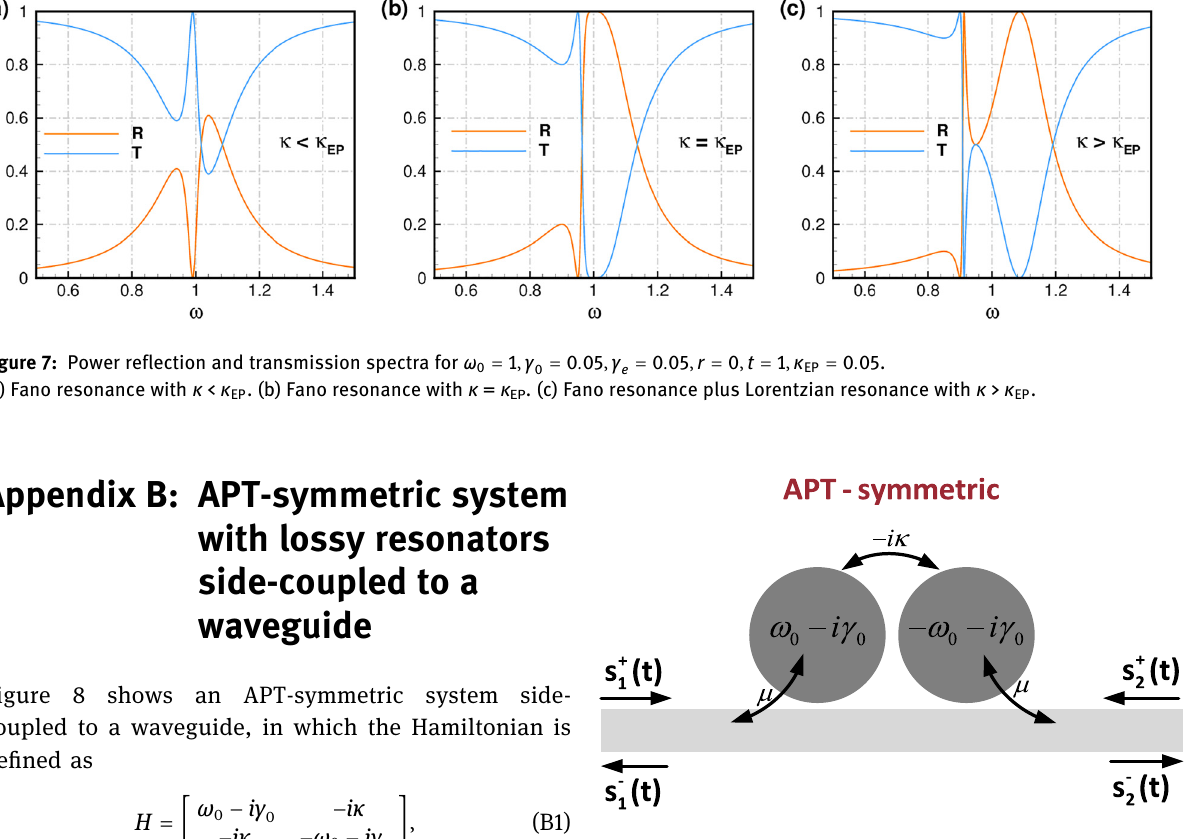
Figure 8: APT-symmetric system side-coupled to a